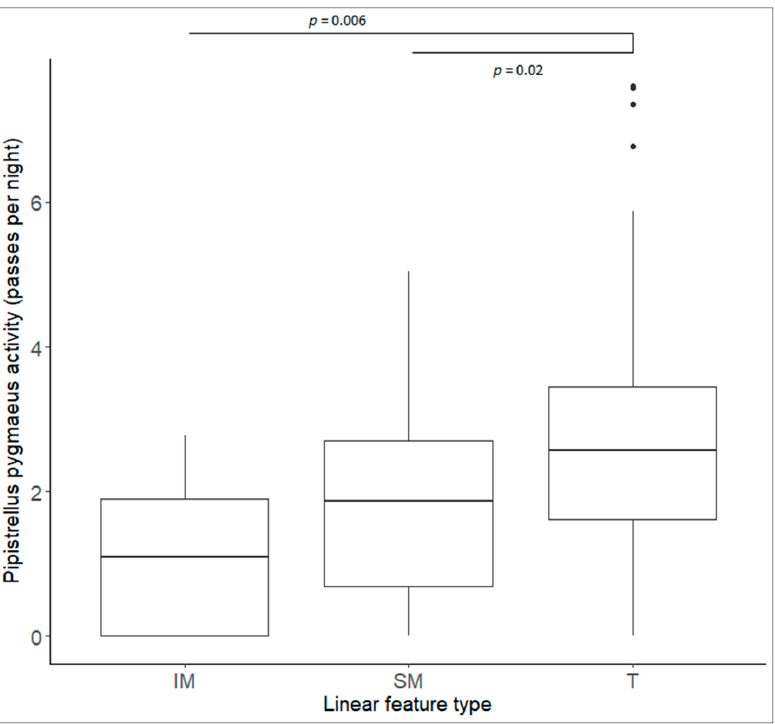
Figure 1. Pipistrellus pygmaeus activity (logged) along intensively managed hedgerows (IM), sympathetically managed hedgerows (SM) and treelines (T). Boxplots showing median activity with the black dots representing outliers.